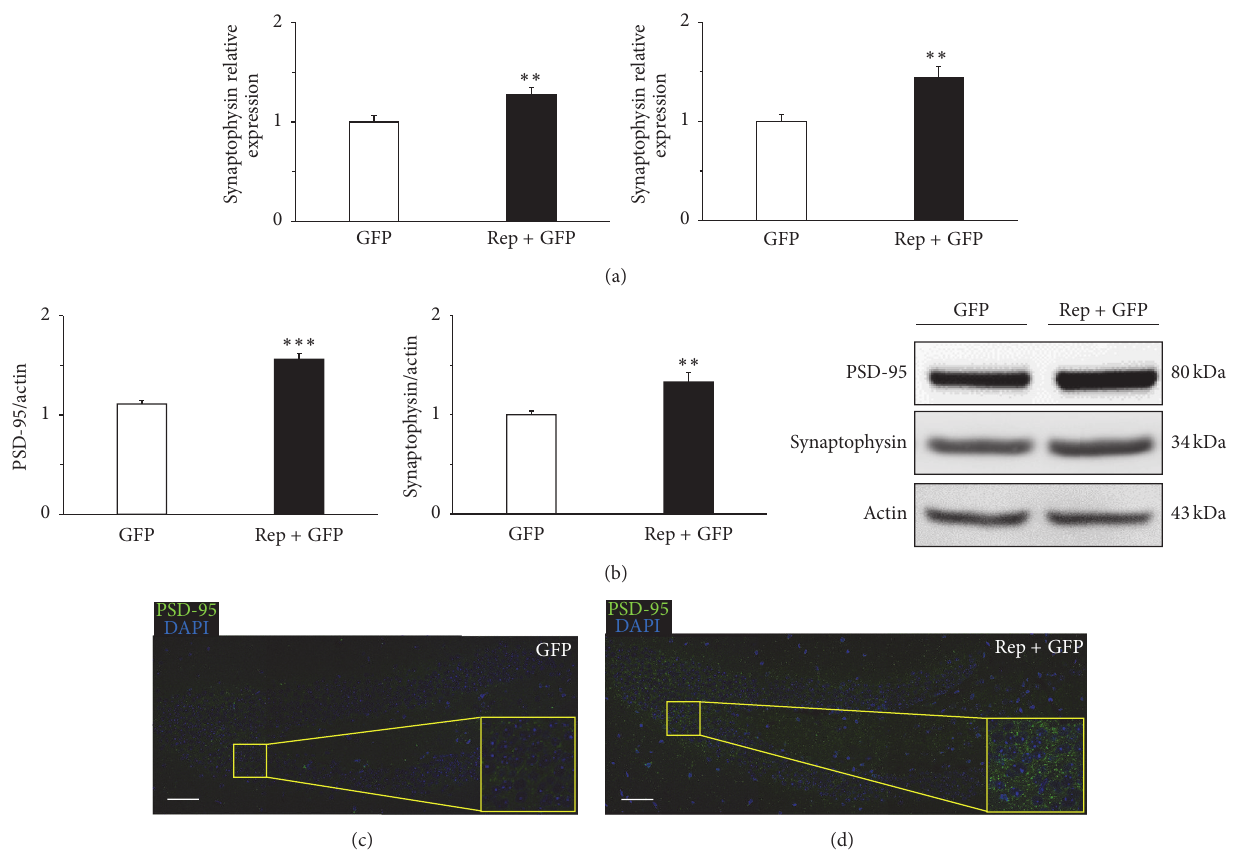
Figure 5: Synaptic density in the hippocampus increased by in vivo expression of reprogramming factors. The expression levels of the synaptic markers of PSD-95 and synaptophysin in the hippocampus were determined by quantitative real-time reverse transcription-polymerase chain reaction (qRT-PCR) and western blot ( 𝑛 = 3 per group). (a) qRT-PCR analysis confirmed that PSD-95 and synaptophysin levels were significantly higher in the treatment group than the control group ( 𝑡 = 2.879 , 𝑝 < 0.01 ; 𝑡 = 3.668 , 𝑝 < 0.01 , resp.). (b) Western blot analysis also confirmed that PSD-95 and synaptophysin levels were significantly higher in the treatment group than the control group ( 𝑡 = 6.499 , 𝑝 < 0.001 ; 𝑡 = 3.136 , 𝑝 < 0.01 , resp.). (c, d) Confocal microscope images are immunohistochemistry results that showed the area of the dentate gyrus in the hippocampus. The expression of PSD-95 in the yellow box represented the difference of synaptic density in the control (c) and treatment (d) group. Scale bars = 50 𝜇 m. ∗∗ 𝑝 < 0.01 ; ∗∗∗ 𝑝 < 0.001